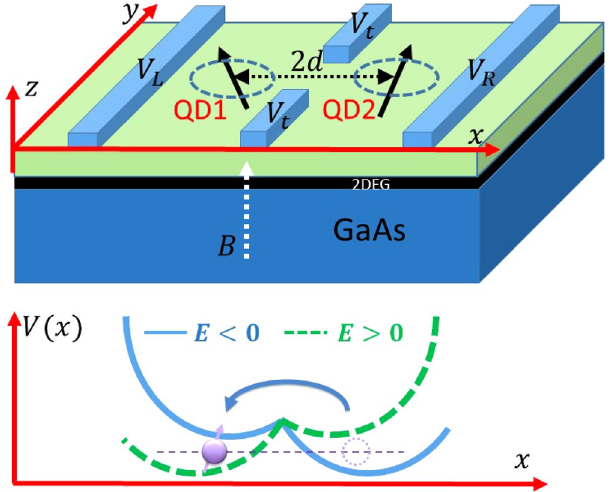
Figure 1. Sketch of our protocol for electron transport in a double quantum dot. The two-dimensional DQD resides at the interface of GaAs and the barrier material, with the growth-direction confinement much stronger than the in-plane confinement. The regions “QD1” and “QD2” label the two dots. Surface gates V L and V R can be used to adjust the detuning between the two dots, while V t can be used to tune the tunnel coupling